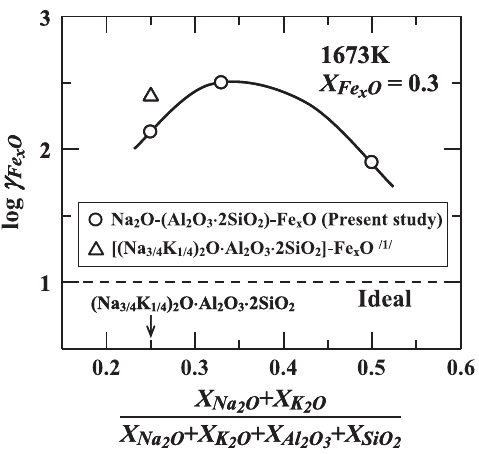
O /SiO mole ratio of 33/67 at 2 3 2